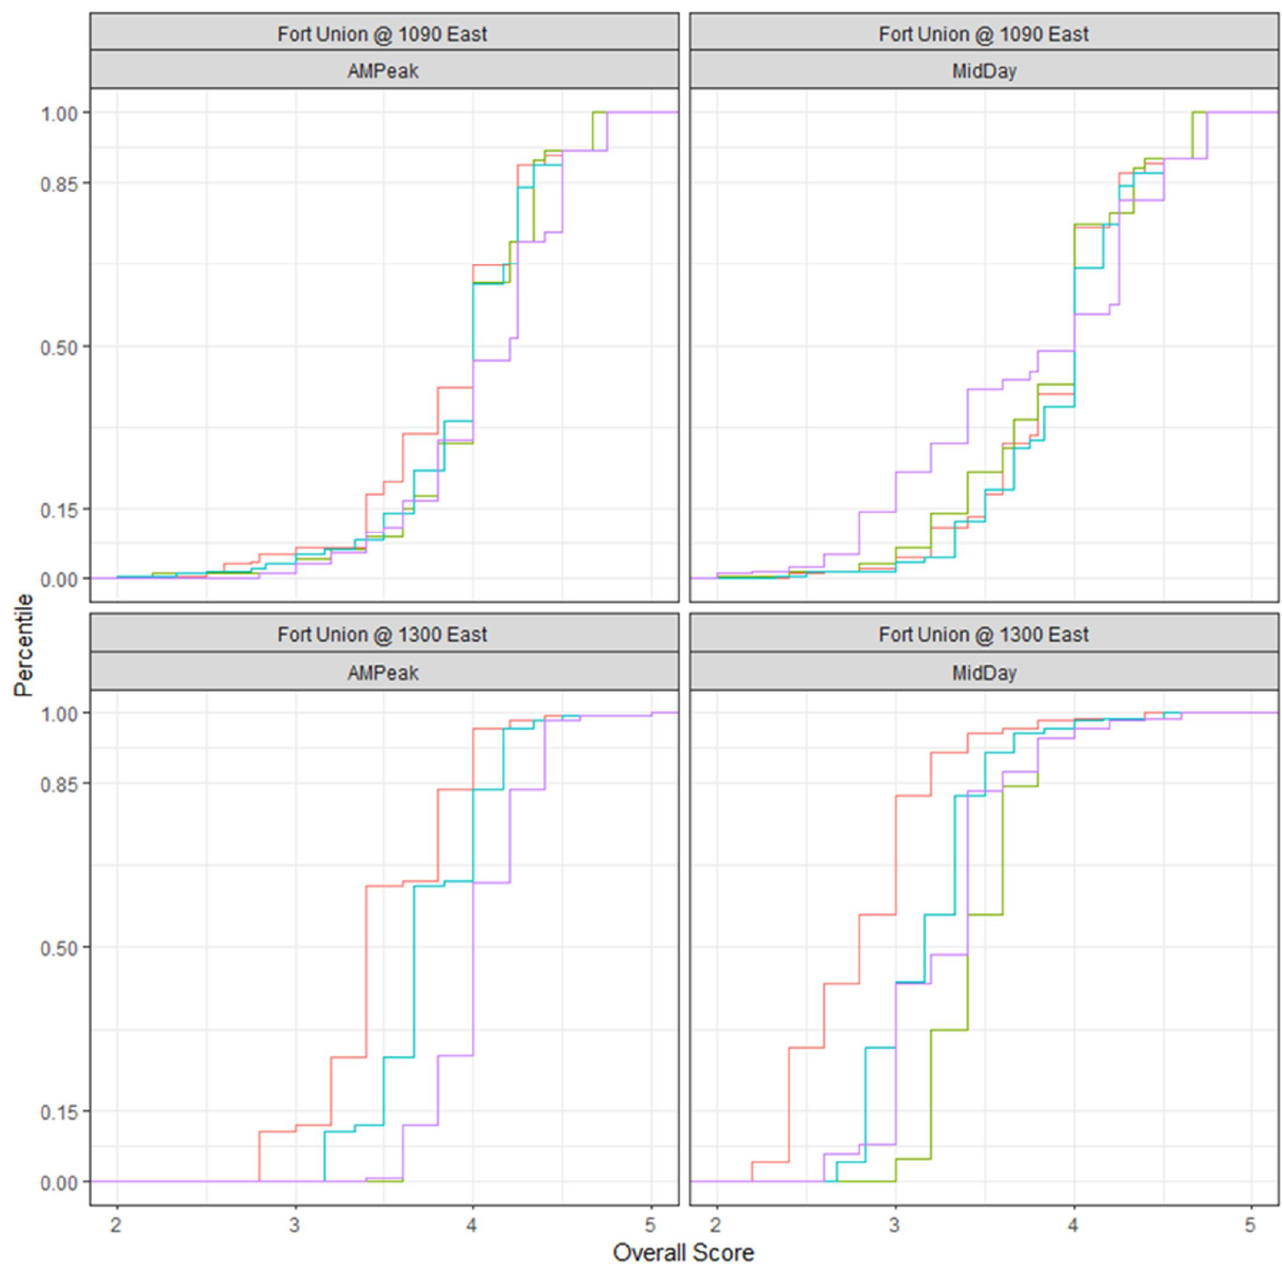
Figure 4. Empirical cumulative distribution for the different weighting schemes.